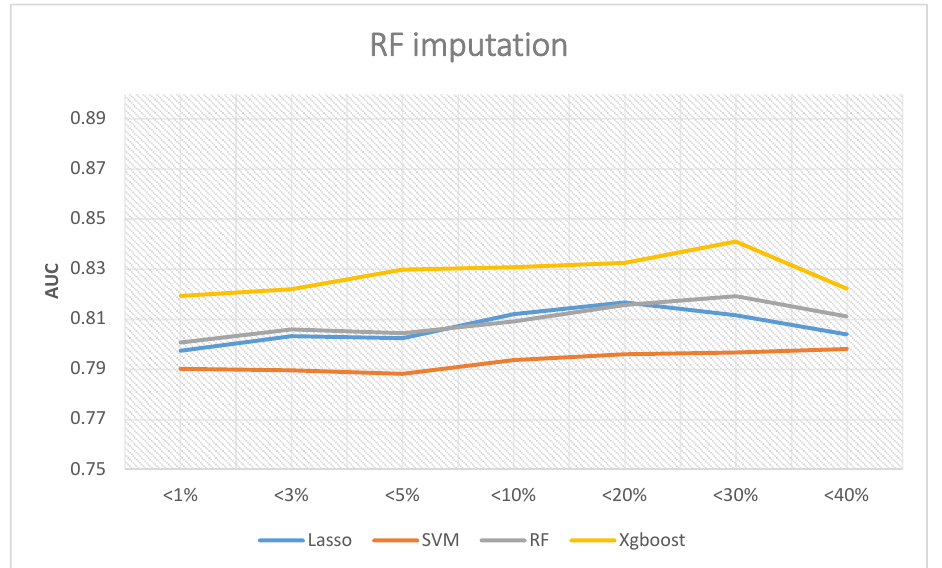
Figure 7. AUC with RF